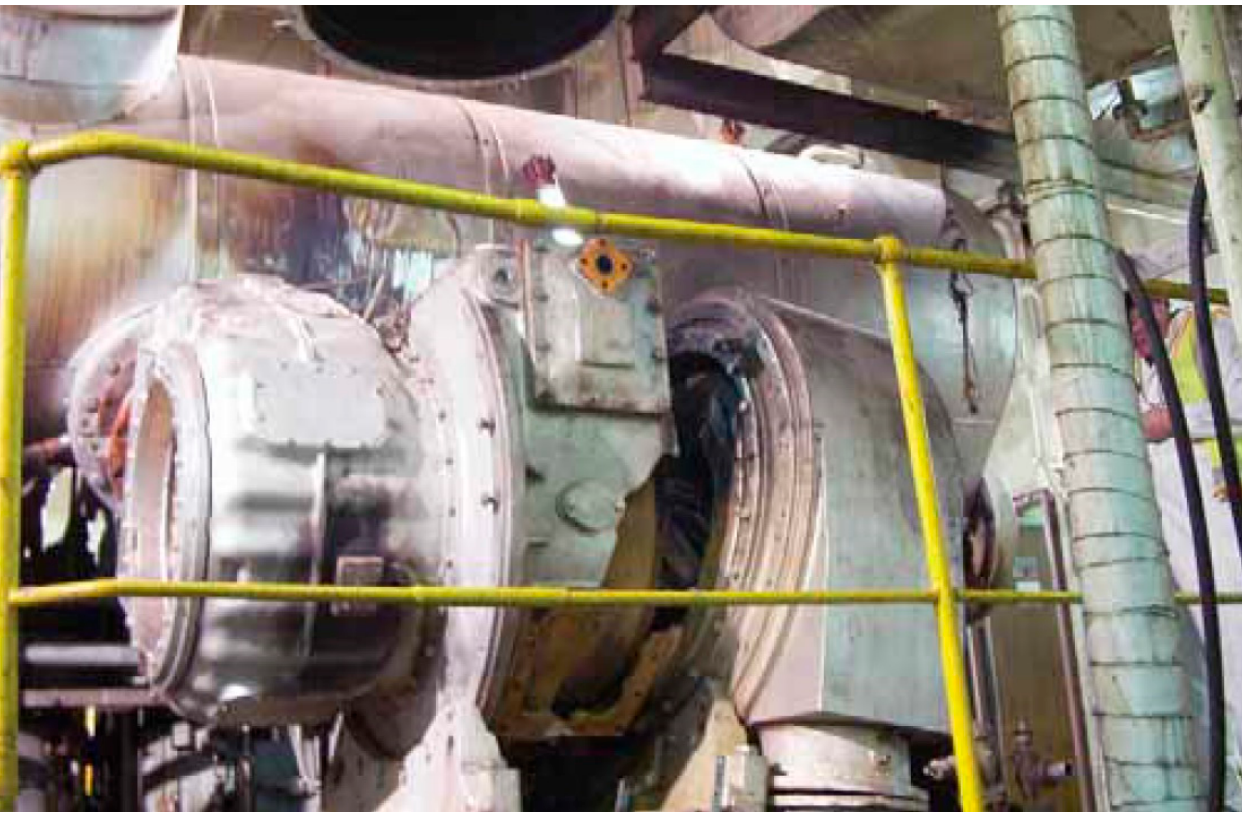
Figure 2. View of the turbocharger of the main engine of the ship m/v Goliath after the explosion on 22.09.2002 (Australian Transport Safety Bureau, 2006).